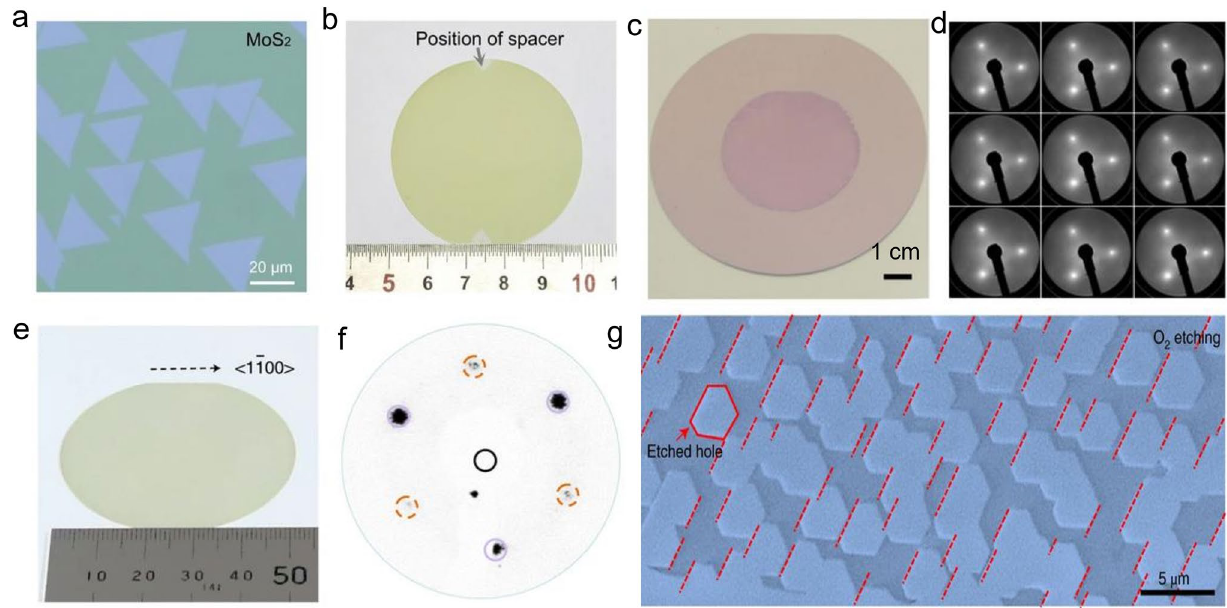
Fig. 10 The wafer-scale growth of MoS 2 and WS 2 by CVD method. a , b 2-inch polycrystalline MoS 2 film [139], Copyright 2022, Springer Nature. c , d 2-inch single-crystal monolayer MoS 2 film and its LEED patterns over a 1 cm 2 area [108], Copyright 2021, Springer Nature. e – g 2-inch single-crystal monolayer WS 2 film and the representative LEED pattern [140], Copyright 2022, Springer